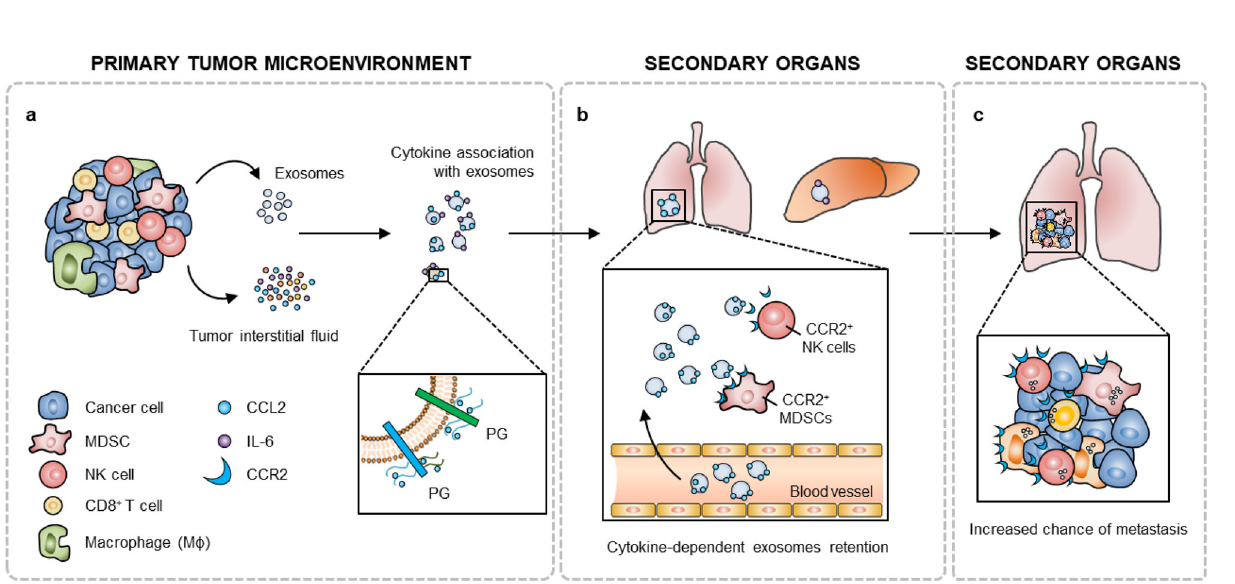
Fig. 5 CCL2 binding affects the in vivo biodistribution of BC exosomes and facilitates BC metastasis. a , b DiD-labeled EO771 exosomes previously incubated (BC exo + CCL2, n = 6 animals) or not (BC exo, n = 8 animals) with CCL2 were injected into C57Bl/6 WT mice, and biodistribution assessed 24 h after injection. a Representative ex vivo images of DiD fl uorescence in various organs from WT mice (clockwise from top-left: liver, spleen, kidney, lung, heart and bone marrow). b Quanti fi cation of DiD fl uorescence in the same organs as shown in a (BC exo; black squares) (BC exo + CCL2; black triangles). c Frequency of CCR2 + population within lung ( n = 12 animals), liver ( n = 13 animals), bone marrow ( n = 12 animals) and spleen ( n = 13 animals) CD45.2 + cells as assessed by fl ow cytometry. d Frequency of CCR4 + and/or CCR2 + populations within CD45.2 + cells in the lung. e , f C57Bl/6 WT mice were injected with DiD-labeled EO771 exosomes previously incubated (BC exo + CCL2, n = 6 animals; black squares,) or not (BC exo, n = 9 animals; black triangles) with CCL2. e Frequency of DiD + population within CD45.2 + cells in the lung. CCR2 + and CCR2 − subpopulations were gated and analyzed separately. f Frequency of DiD + population within distinct CD45.2 + immune cell subsets. CCR2 + and CCR2 − subpopulations were gated and analyzed separately. g – i DiD-labeled EO771 exosomes previously incubated (BC exo + CCL2, n = 6 and n = 5 animals in the WT and CCR2 − / − groups, respectively; black triangles) or not (BC exo, n = 6 and n = 9 animals in the WT and CCR2 − / − groups, respectively; black squares) with CCL2 were injected into C57Bl/ 6 WT and CCR2 − / − mice, and biodistribution assessed 24 h after injection. g Representative ex vivo images of DiD fl uorescence in various organs from WT and CCR2 − / − mice. h Quanti fi cation of DiD fl uorescence in the lung as shown in g . i Frequency of DiD + population within CD45.2 + cells in the lung of WT and CCR2 − / − mice. j , k Mice pre-conditioned with cell culture-derived EO771 exosomes previously incubated (BC exo + CCL2, n = 7 and n = 5 animals in the WT and CCR2 − / − groups, respectively; black triangles) or not (BC exo, n = 7 and n = 5 animals in the WT and CCR2 − / − groups, respectively; black squares) with CCL2 received a single i.v. injection of EO771 cells, and metastatic burden in the lung was assessed. j Representative lung examined per mouse; all fi ve lobes were analyzed and combined to determine total number of metastases per section). Data are presented as mean ± SEM.